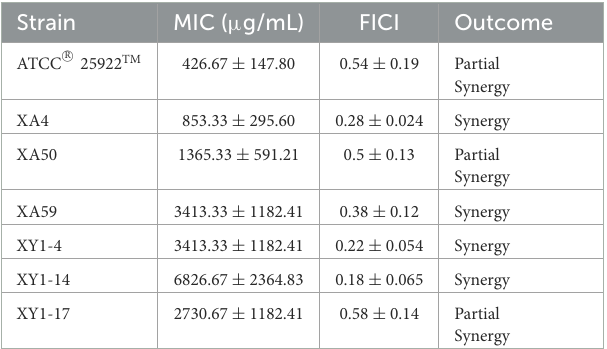
TABLE 2 Results of MIC (magnolol) and FICI (magnolol × cefquinome) for seven E. coli